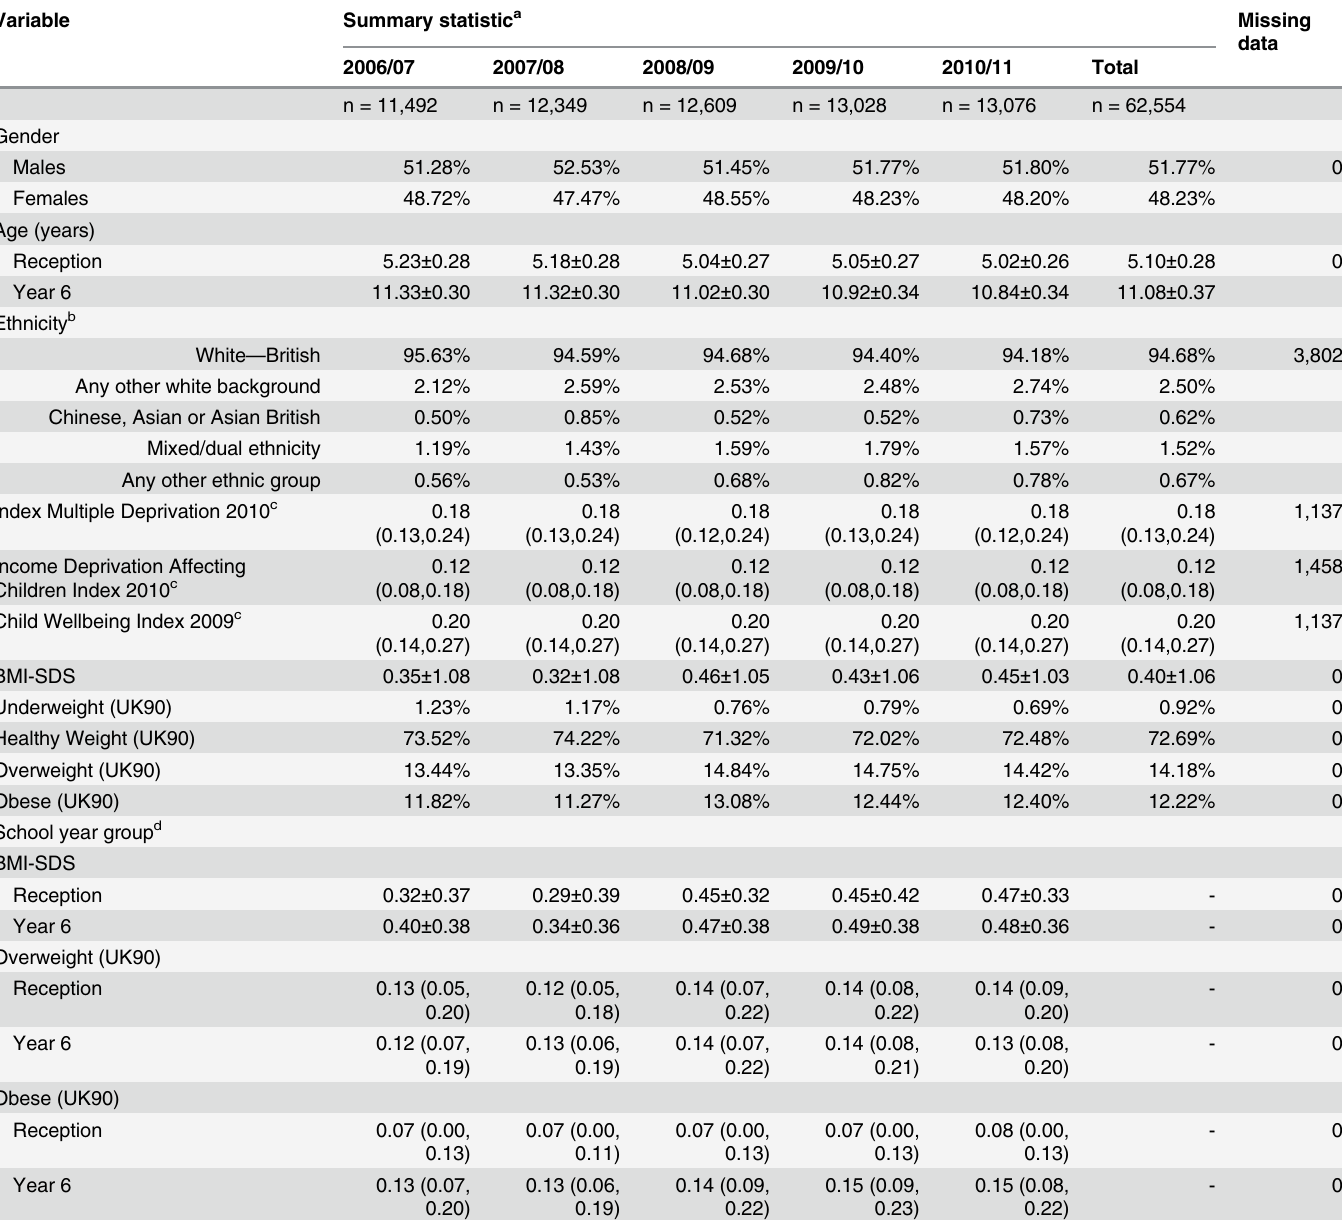
Table 2. Individual